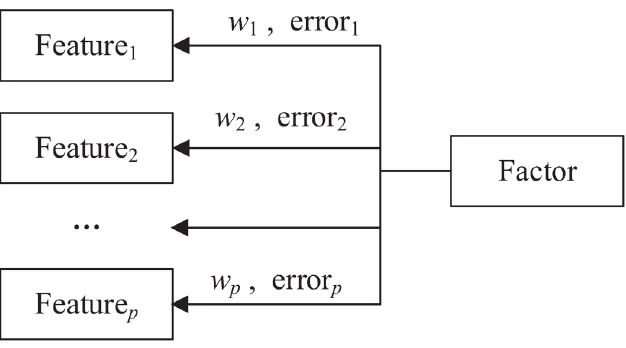
Fig 1. An example of the relationship between a factor and its observed